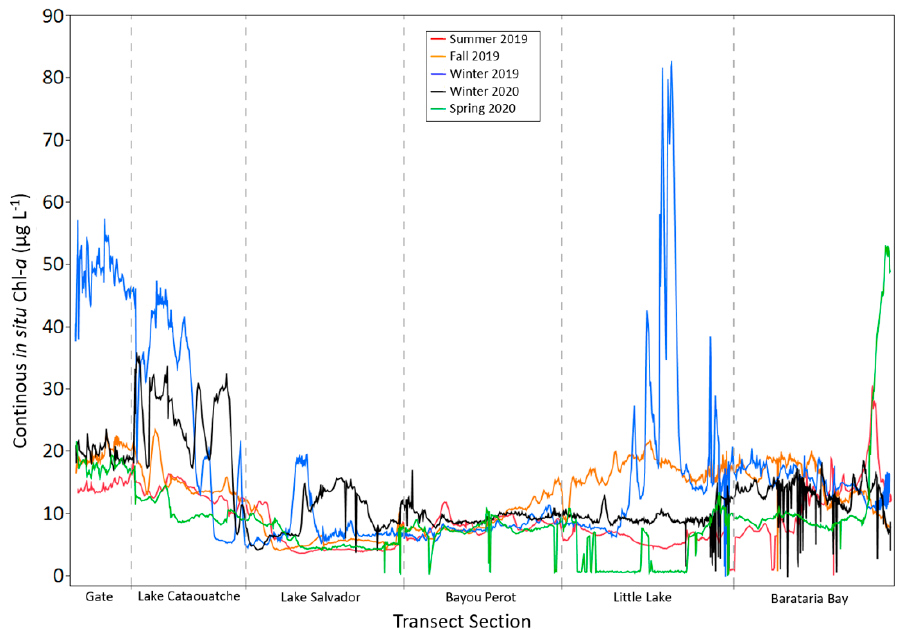
Figure 6. Spatial distribution of continuous in situ Chl- a concentration measurements in the BB complex for the period 2019–2020. Surveyed using the SWAMMP-R (see methods). Sampling